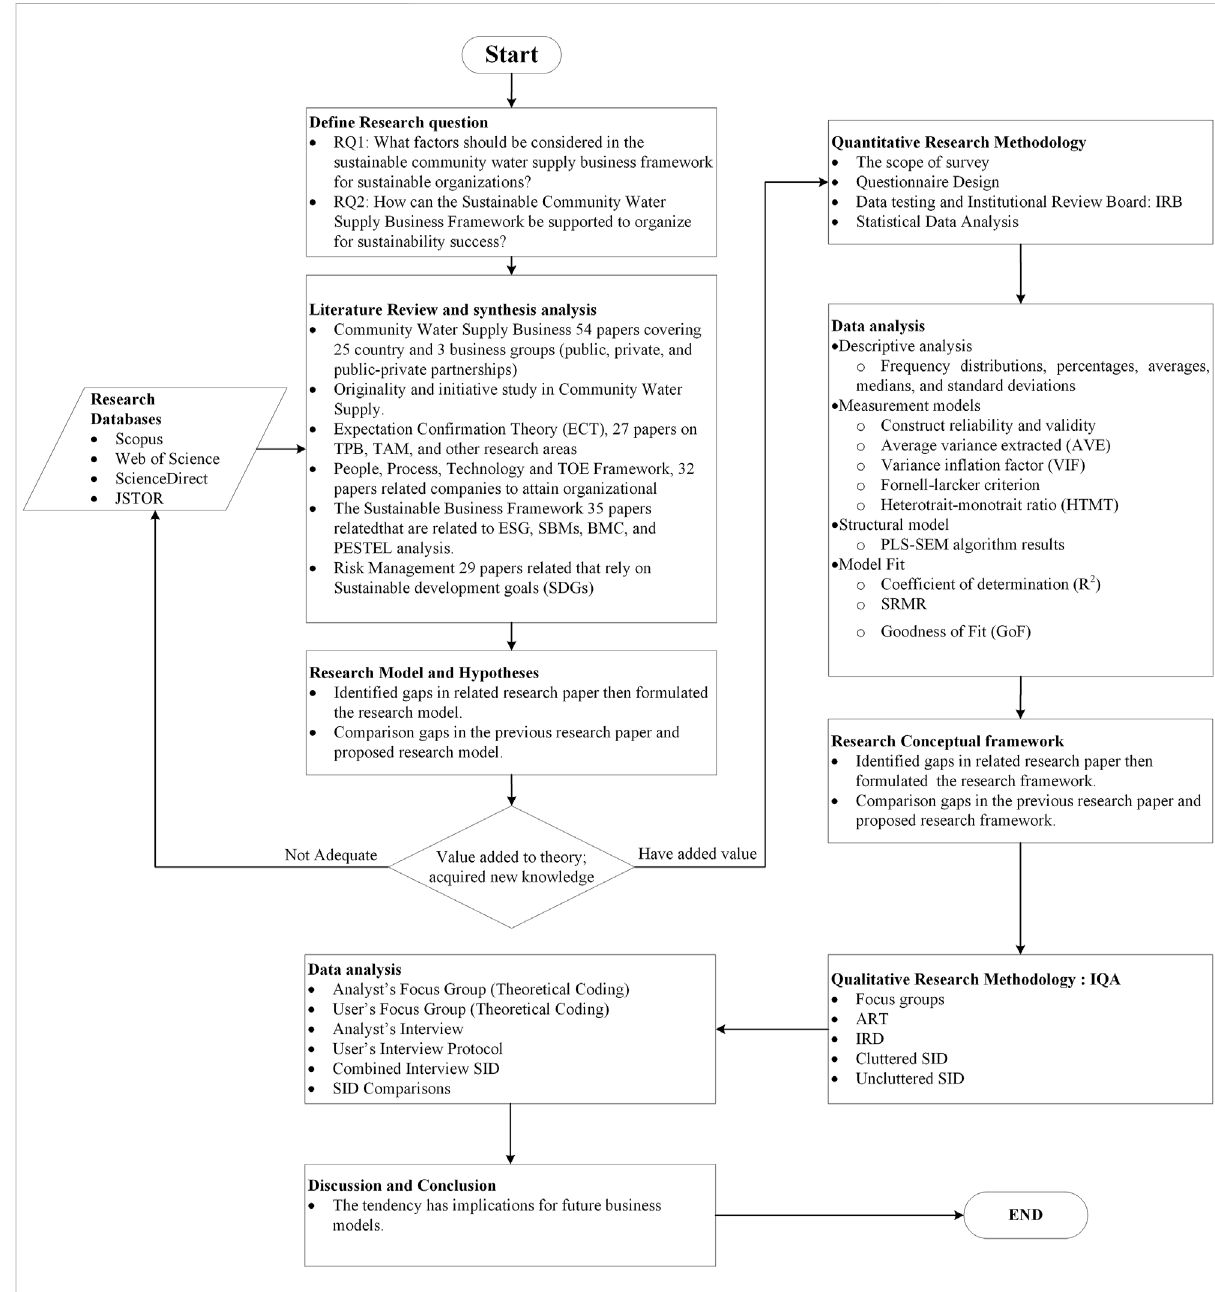
FIGURE 2 Flowcharts of quantitative and qualitative research methodology